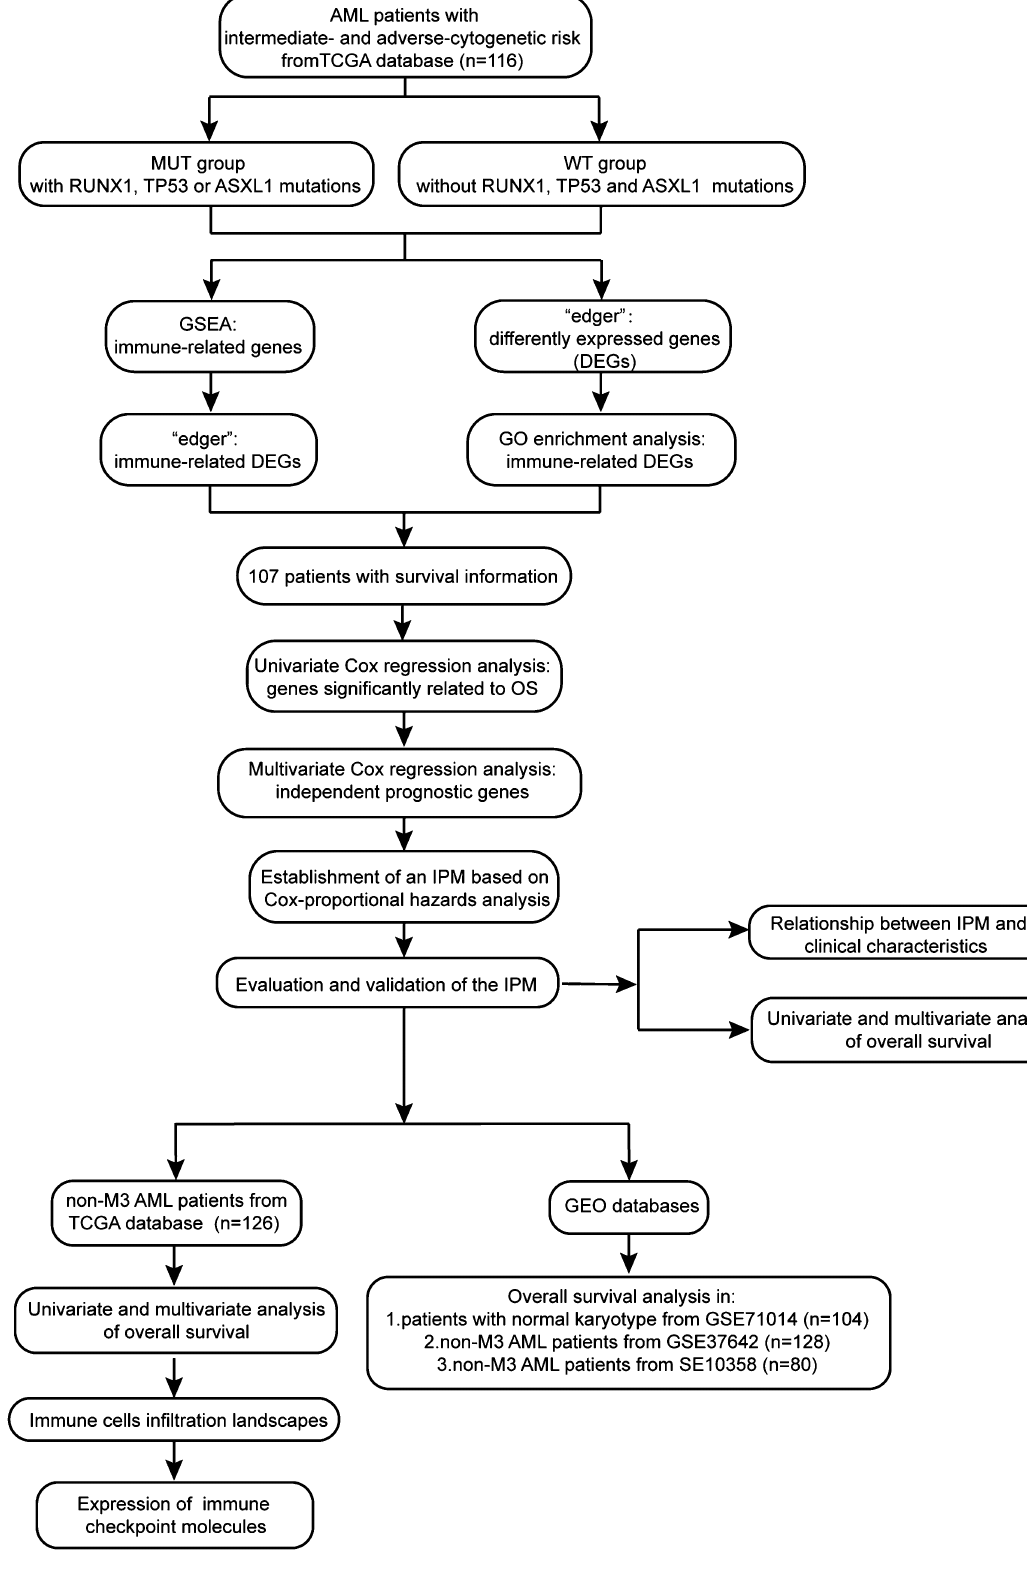
Figure 5. Workflow chart of data generation and